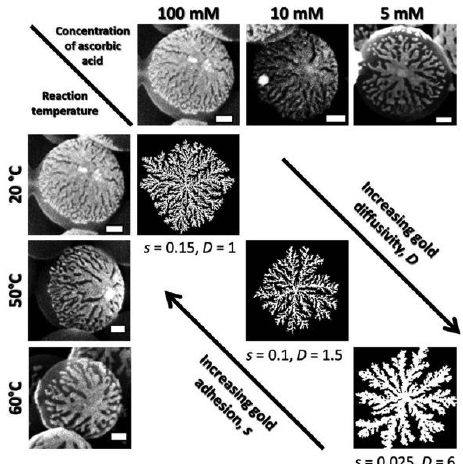
Figure 9. Gold ion seeding method: Effect of reaction temperature and reducing agent concentration on gold nanostructure morphology. Reprinted with permission from Reference [62]. Copyright (2014) Royal Society of Chemistry.